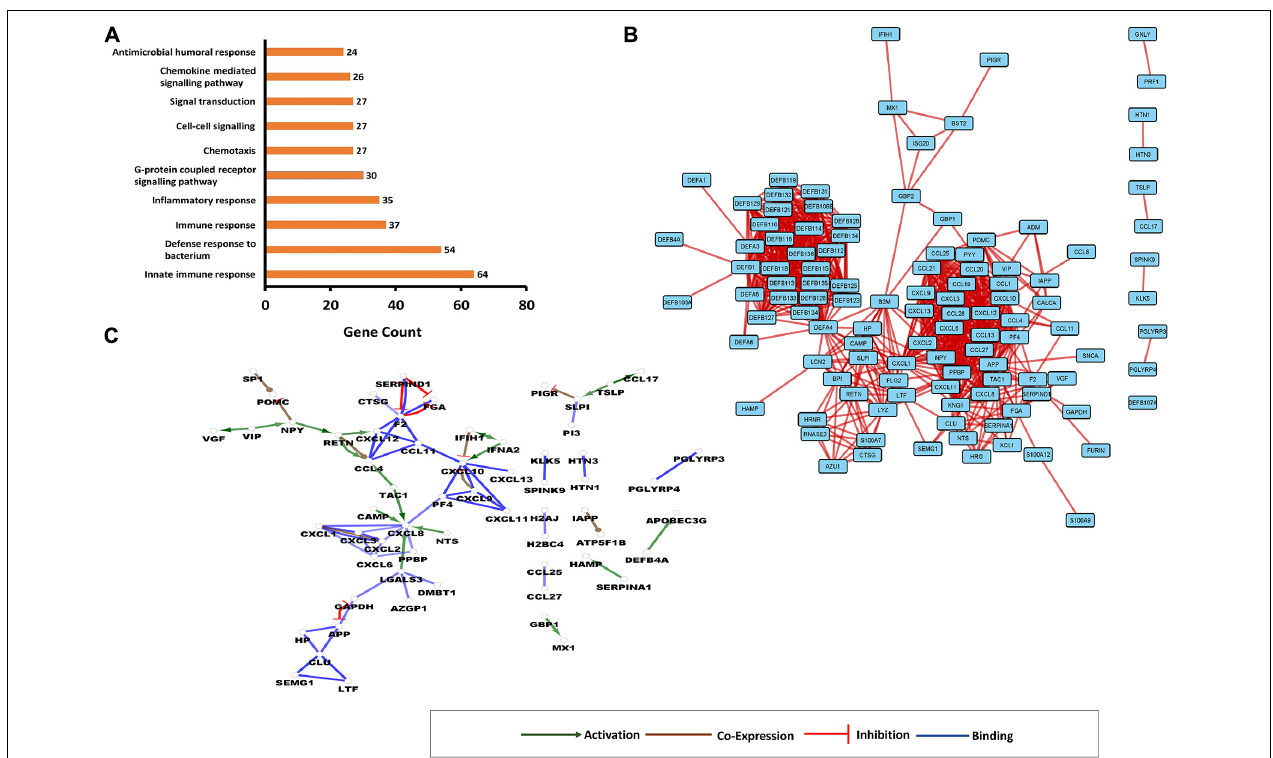
FIGURE 1 | Interaction networks involving human antimicrobial and immunomodulatory peptides (AMPs). (A) Top 10 enriched gene ontology (GO) terms for AMPs present in comprehensive human antimicrobial and immunomodulatory peptide (UDAMP) Database. The enriched GO terms are shown on the “ y ” axis, while the gene counts are shown on the “ x ” axis. (B) Protein–protein interaction (PPI) network. Each rectangle represents a protein, and the line represents the interactions. (C) Gene interaction network (GIN). Circles represent a gene/protein, and the lines indicate interactions. The lines with arrow represent activation, blocking lines represent inhibition, and simple lines represent protein–protein interaction. Line color indicates the type of interaction: green color refers to activation, red color to inhibition, blue color binding, whereas brown color shows co-expression. On all panels, the proteins are labeled with their gene name. The higher resolution images of the networks are presented in Supplementary Figure 1